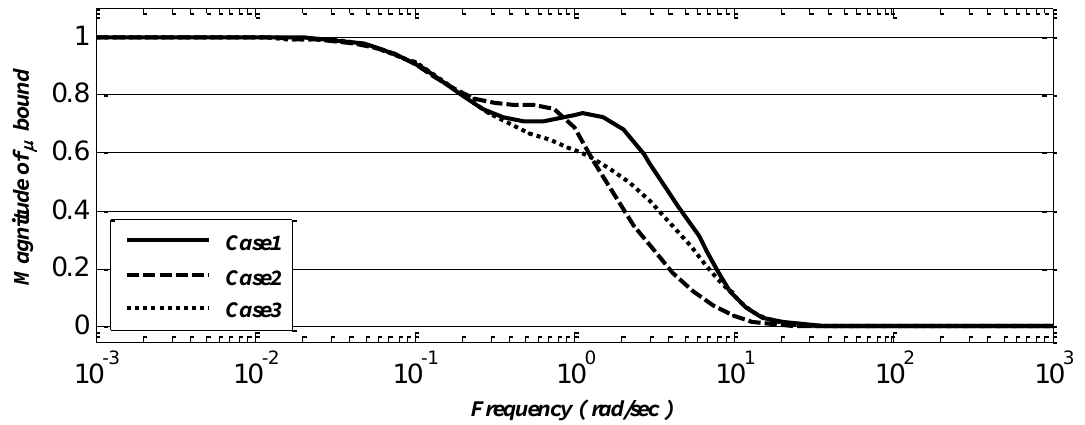
Figure 13b. μ bound of the closed-loop performance with designed local